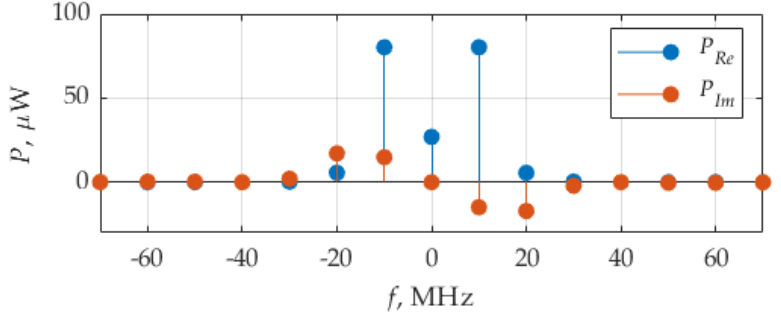
Figure 12. Average power frequency distribution for the case of pulse train current.